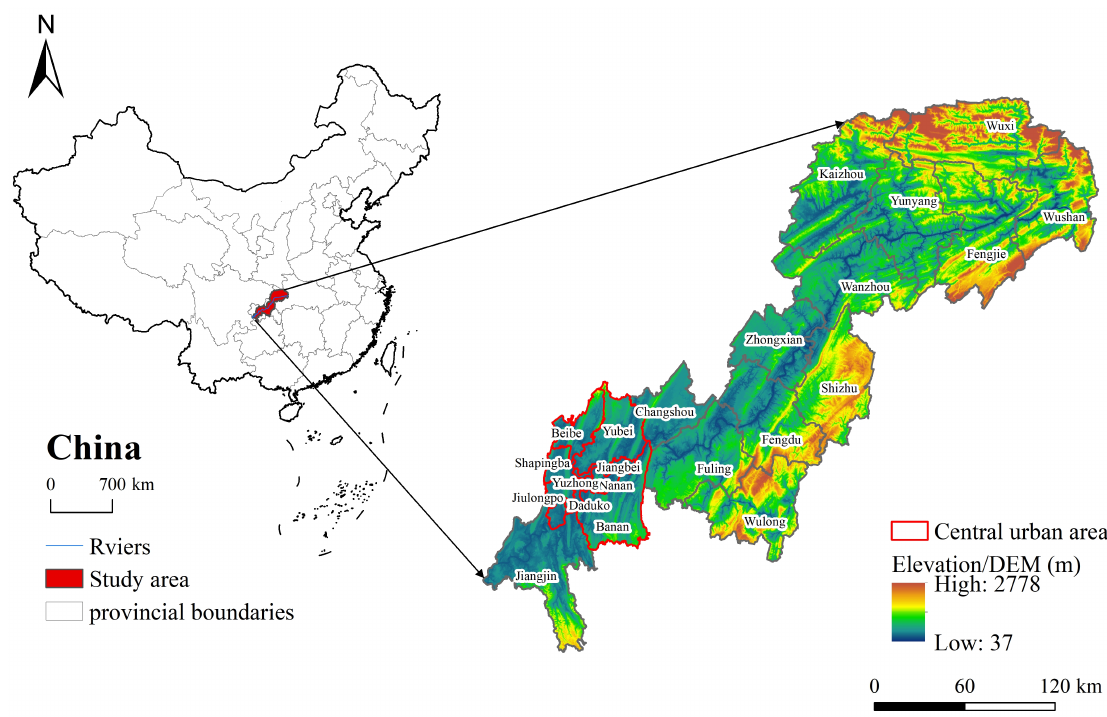
Figure 1. Geographical location and overview of the study area.